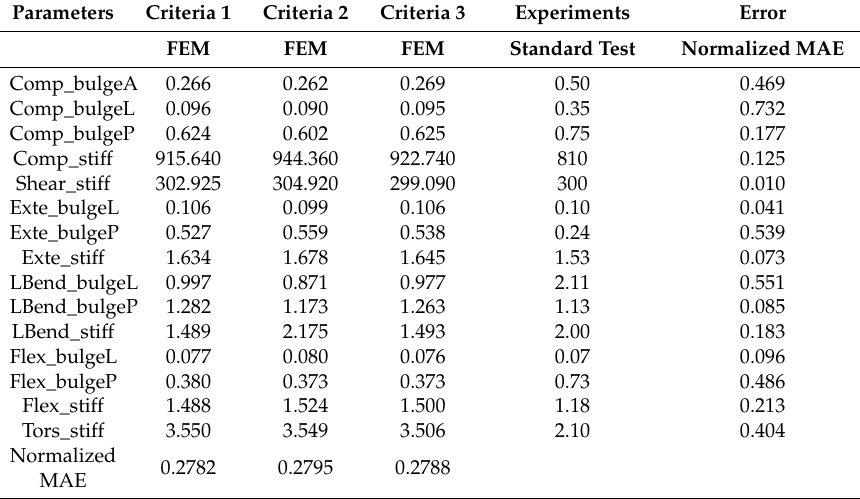
Table 31. Comparison of the results of the regression models; FEM and the experimental